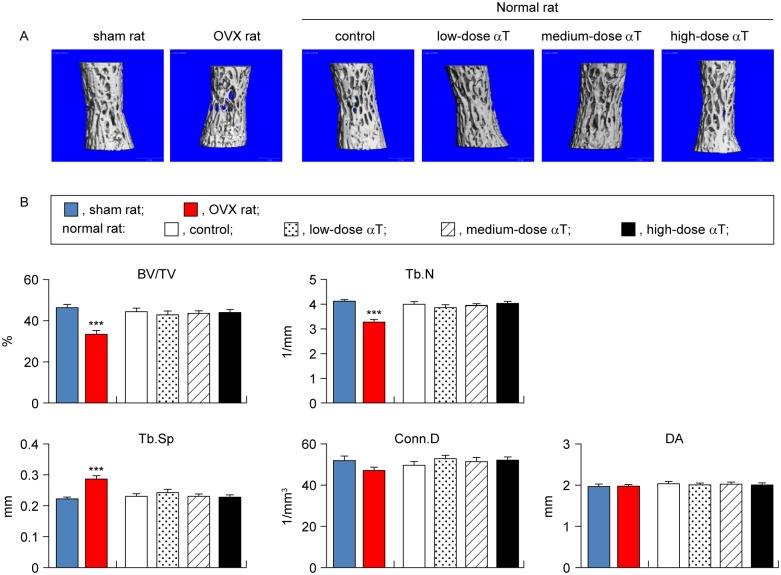
Micro-CT analysis of trabecular bone in vertebral body.(A) Representative 3-dimensional micro-CT images of trabecular bones in vertebral bodies are shown. (B) Microstructural parameters (BV/TV, trabecular bone volume fraction; Tb.N, trabecular number; Tb.SP, trabecular separation; Conn.D, connectivity density; DA, degree of anisotriphy) of trabecular bones in vertebral bodies are shown. Data are presented as mean ± standard error of the mean. ***P < 0.001 vs. sham rat group.